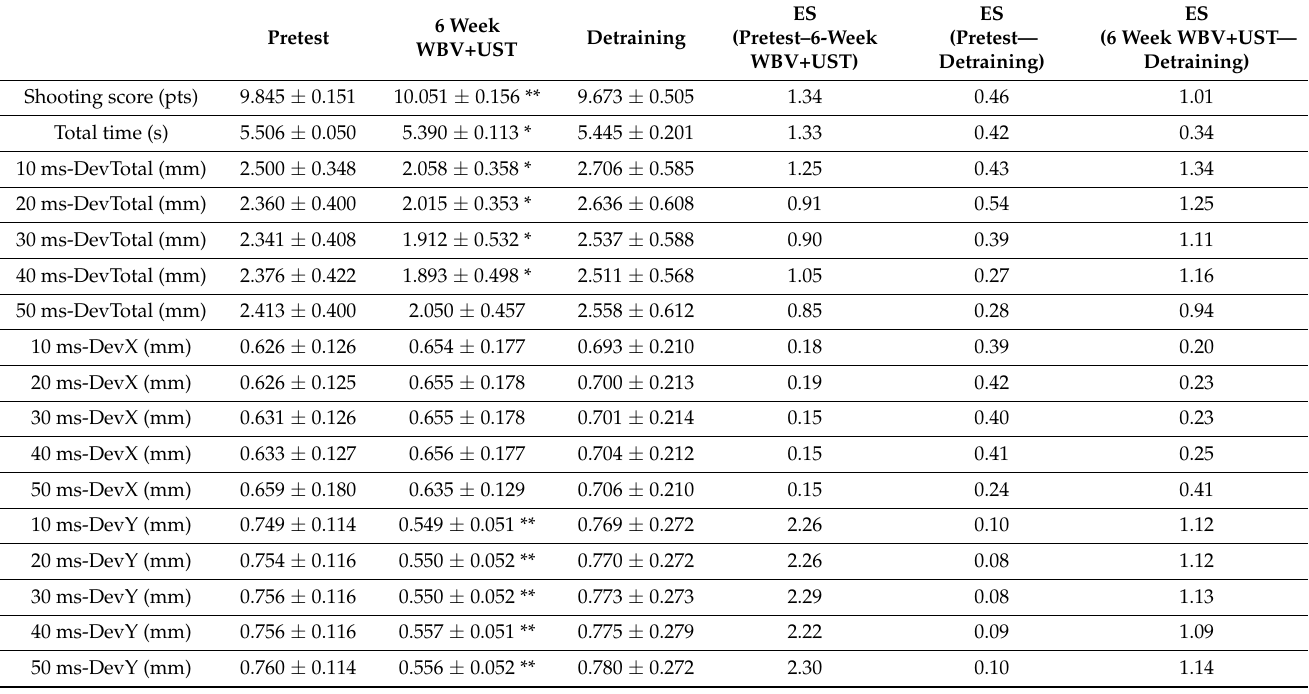
Table 3. Descriptive statistics of the shooting test.